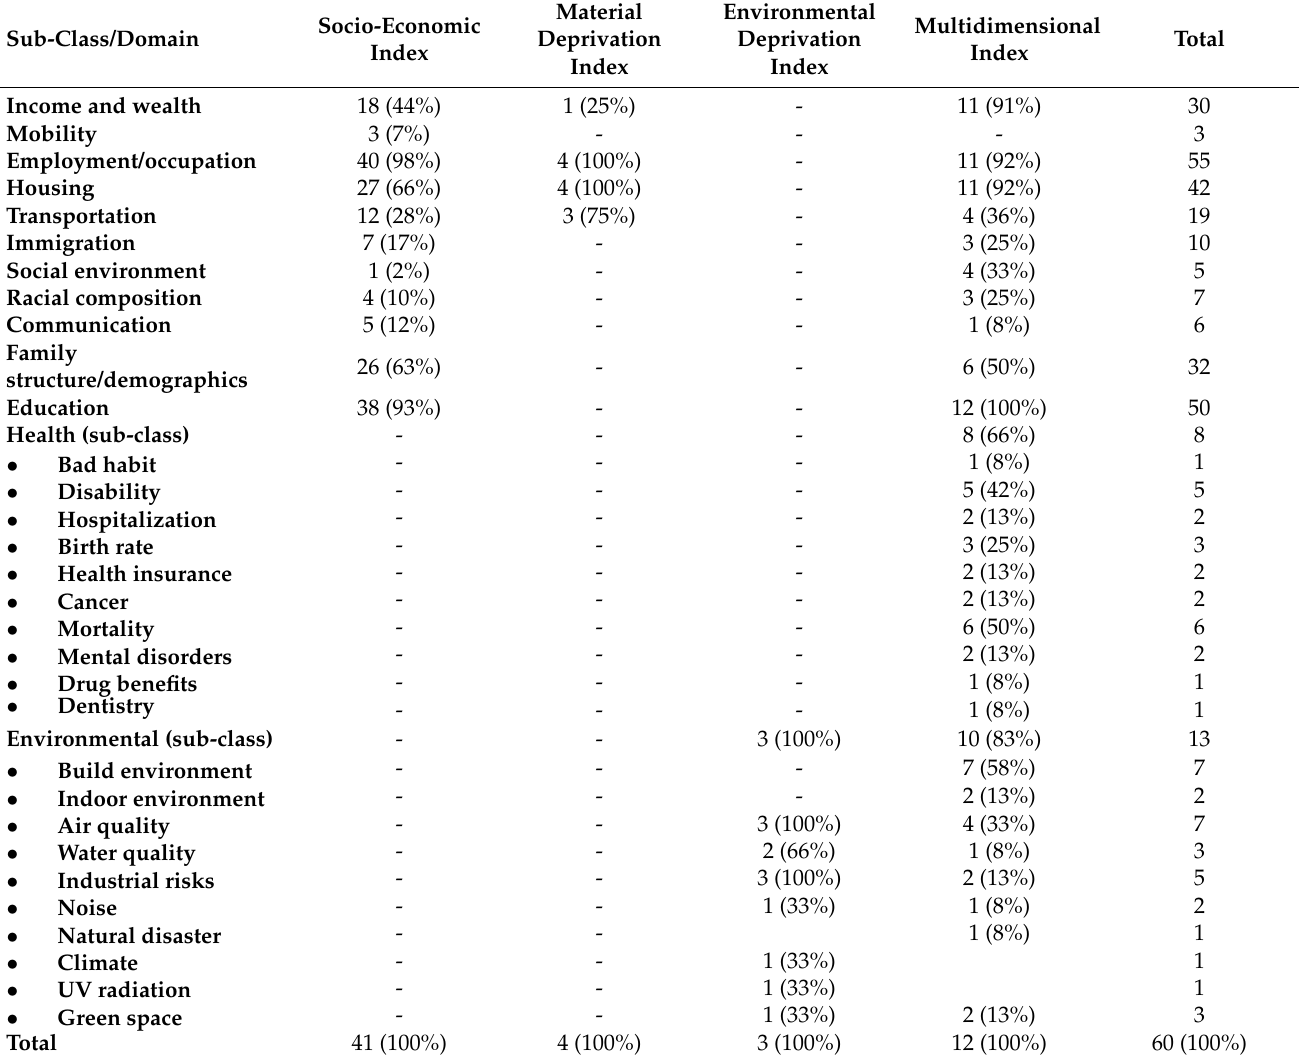
Table 1. Distribution of indicators of deprivation (domains) depending on the type of